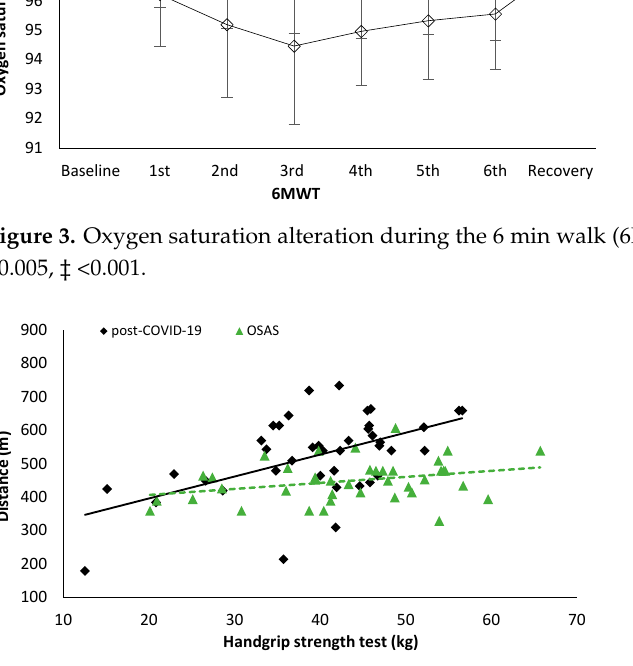
handgrip and distance during the 6MWT (r = 0.322, p = 0.044, Figure 4), anthropometric 0.001; body mass: r = 0.370, p = 0.019; lean body mass: r = 0.522, p = 0.001; percent of body fat: r = − 0.499, p = 0.001; total body water: r = 0.672, p < 0.001; neck circumference: r = 0.474, p = 0.002); and estimated O 2 uptake (r = 0.325, p = 0.041). In post-COVID-19 patients, sta- tistically significant correlations were detected between handgrip and distance covered during the 6MWT (r = 0.540, p < 0.001, Figure 4), anthropometric characteristics, and body